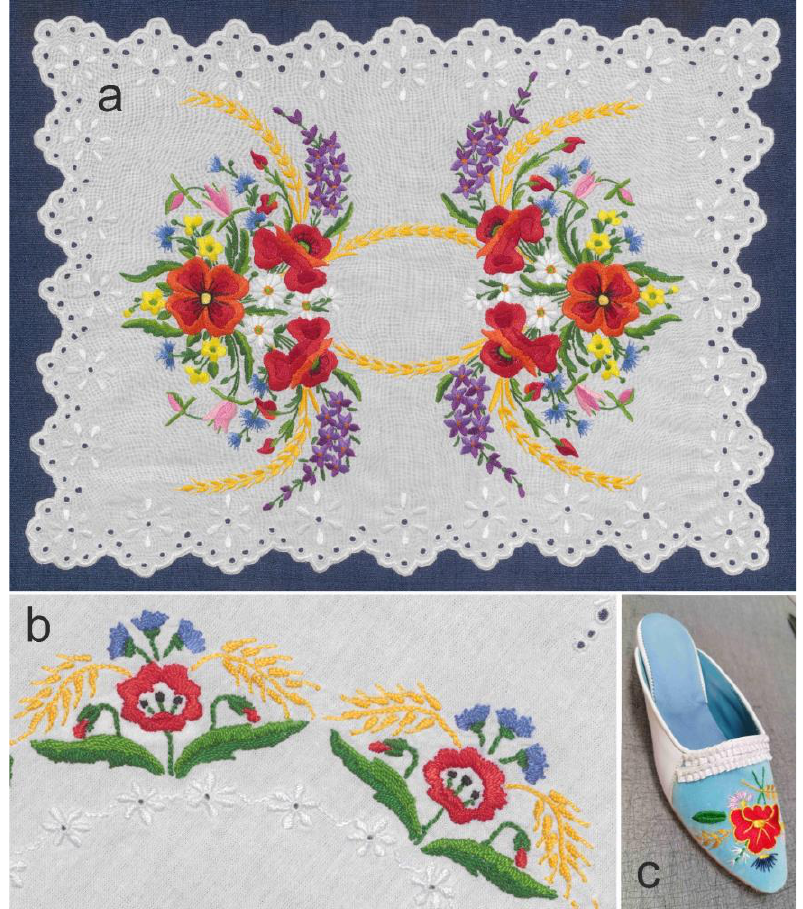
Figure 9. Contemporary folk embroideries with wheat ears and arable wildflowers motifs: ( a , b ) tex- tiles from Vojvodina (N Serbia) with motifs from Ada ( a ) and Torontálvásárhely [Debeljača] ( b ) (both manufactured by Veronika Serfőző, photographs by Ágnes Nagy Abonyi. Courtesy of Rozetta Kézműves Társaság, Zenta); ( c ) Slippers from Szeged (S Hungary, courtesy of Sallay Szegedi Papucs).